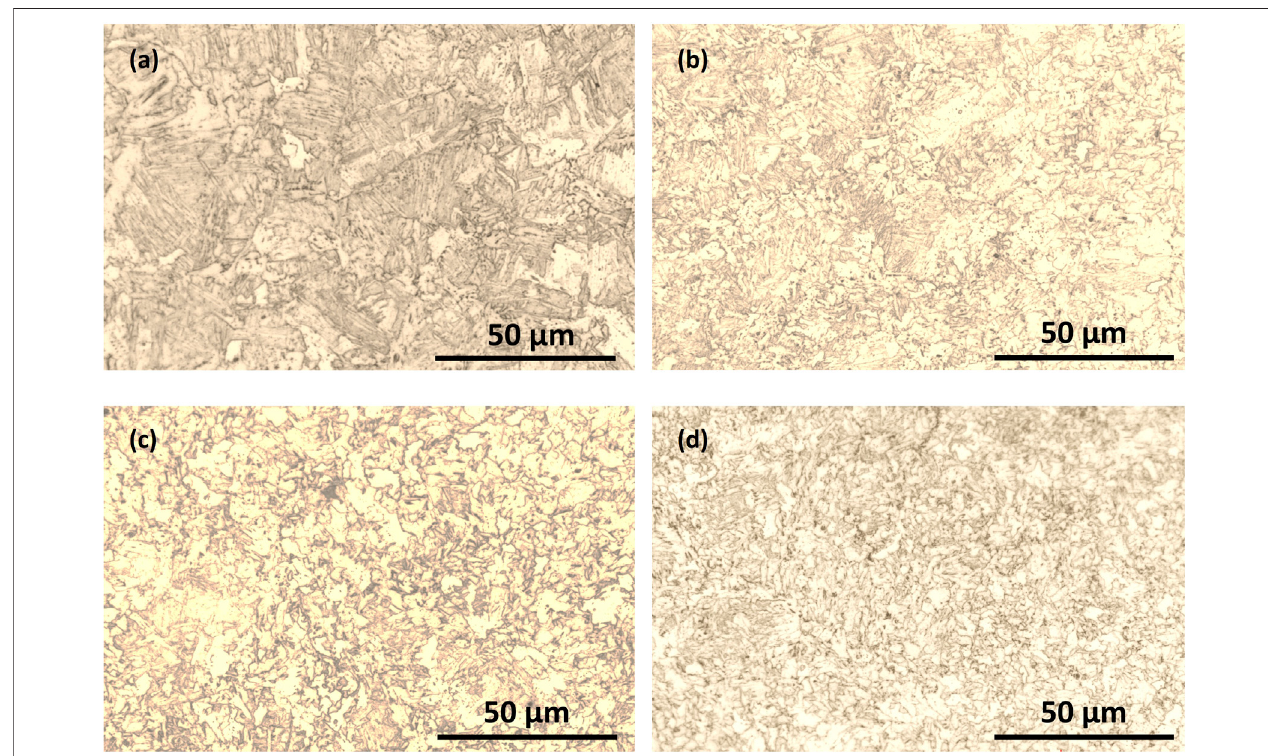
FIGURE5| TheopticalmicrostructuresofX-70steelsubjectedtointerpasstimeof10 s.Thesampleswereimmediatelywaterquenchedafterthe: (A) 1st, (B) 3rd, (C) 5th and (D) 7th passes.